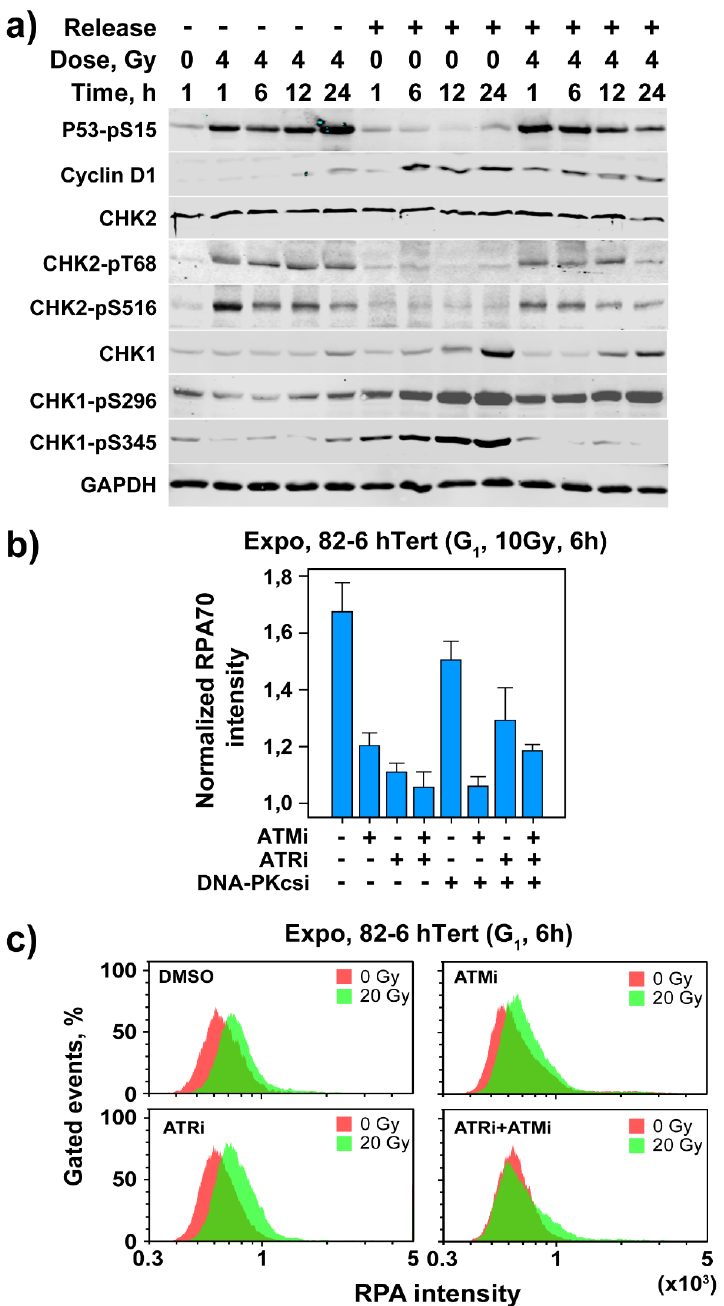
Figure 6. Assessment of cell cycle and checkpoint proteins in irradiated and non-irradiated G 0 cells of SD 82-6 hTert cell cultures with or without transfer to fresh growth medium; analysis of resection at DSBs in G 1 cells of exponentially growing cultures. ( a ) Levels of indicated proteins as a function of time after exposure to 0 or 4 Gy (see text for details). Experiments are reproduced 3 times and a representative one is shown. ( b ) Analysis of DNA end resection at DSBs in G 1 phase after exposure to 10 Gy in the presence or absence of ATMi, ATRi and DNA-PKcsi at the indicated combinations using QIBC as described under “Material and Methods” and RPA70 intensity as endpoint. Plotted is the mean and SE from three independent experiments. See also Table S5 for more information. ( c ) Analysis of DNA end resection at DSBs in G 1 phase after exposure of cells to 20 Gy in the presence or absence of ATMi and/or ATRi as indicated, using flow cytometry as described under “Material and Methods” and RPA70 signal intensity as endpoint. Experiments are reproduced 3 times and a representative one is